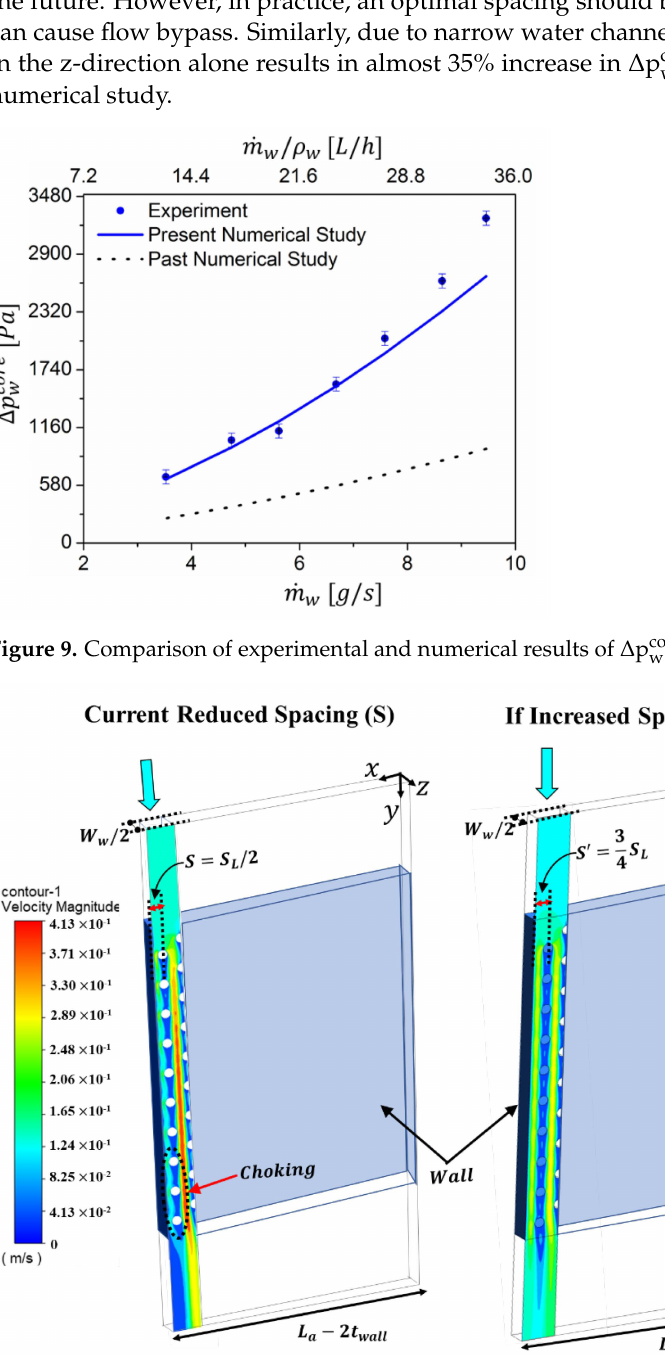
Figure 10. Choking effect around the nearest wires to the wall due to small spacing ( S ) (on left ) and no-choking effect around those wires if S is increased (S’) (on right ) at some particular